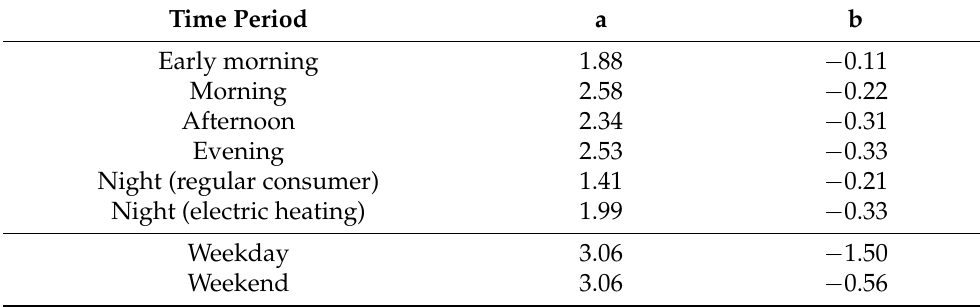
Table 5. Coefficients of the OLS regressions shown in Figures 14 and 15 at the daily and weekly